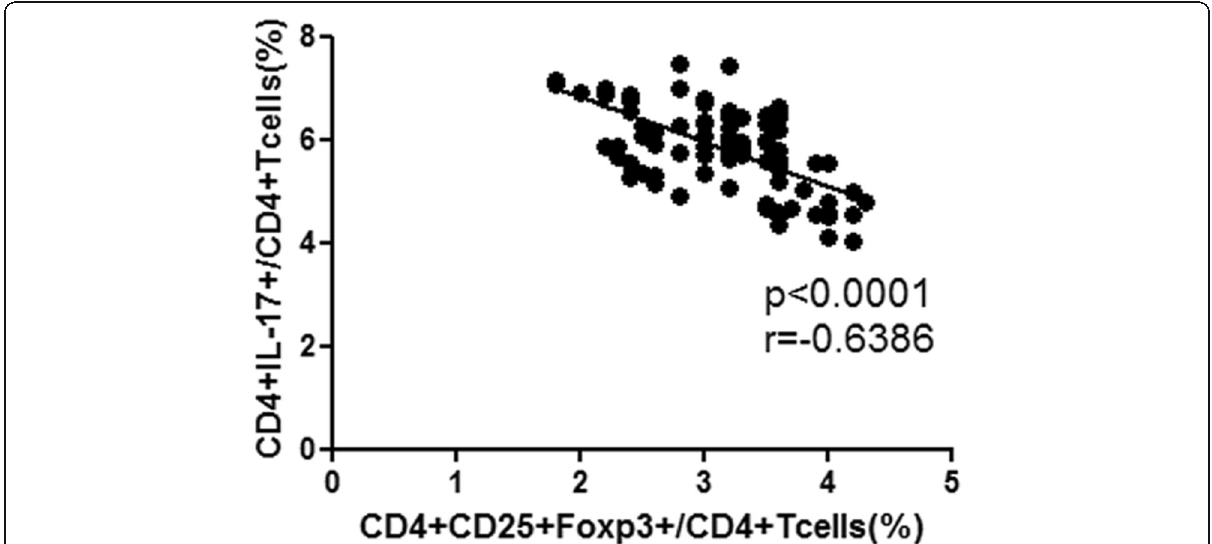
Fig. 3 Negative correlation between Treg and Th17 cells in the peripheral mononuclear cells of the LC group (r = − 0.6386, p < 0.0001, n =